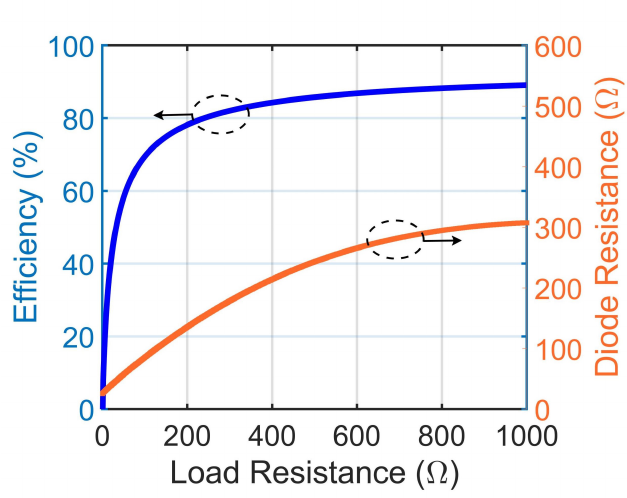
Figure 12. Numerical results of using the SMS 3922 Schottky diode model presented in [25]. The load resistance was varied from 0 to 1000 Ω at 2